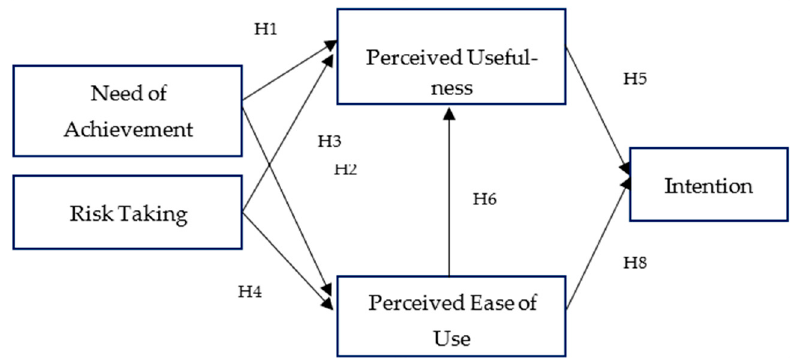
Figure 1. The theoretical